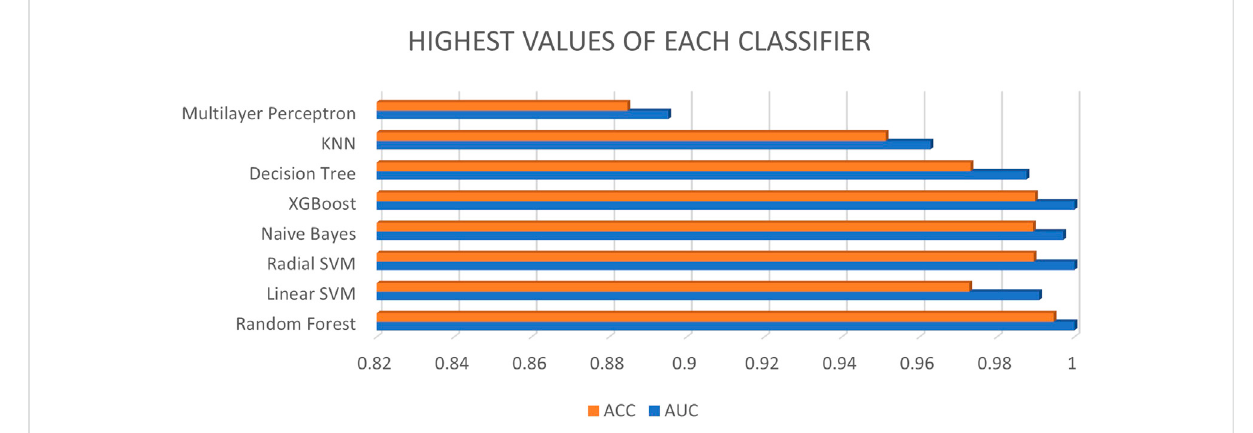
FIGURE 3 Highest values of each classi fi er.